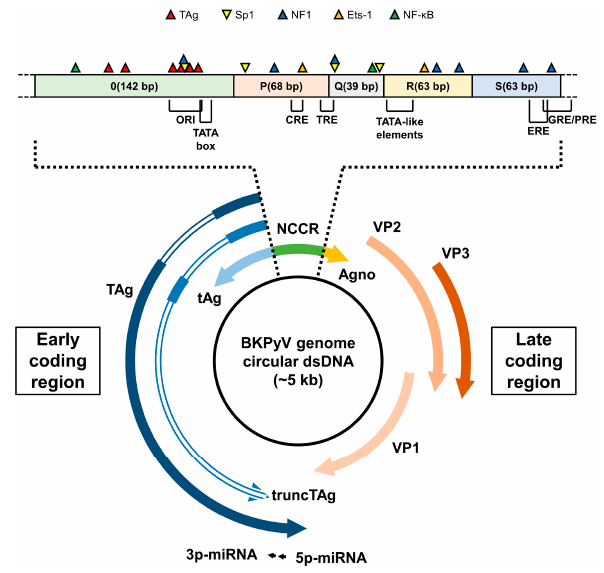
Figure 2. Genome map of BKPyV. ( Bottom ) The BKPyV genome is a closed circular, double-stranded DNA molecule of approximately 5 kb. The transcription of early and late coding regions proceeds in